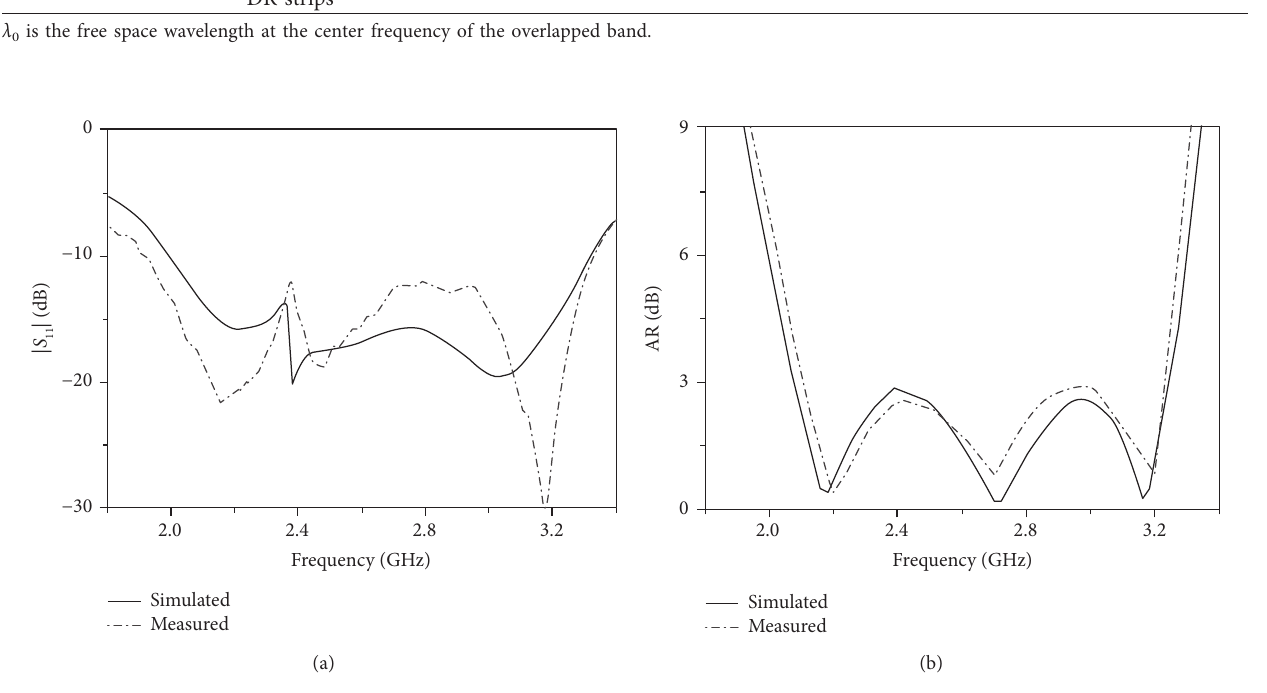
Figure 6: (a) | S 11 | and (b) AR curves of simulated and tested antenna prototype.